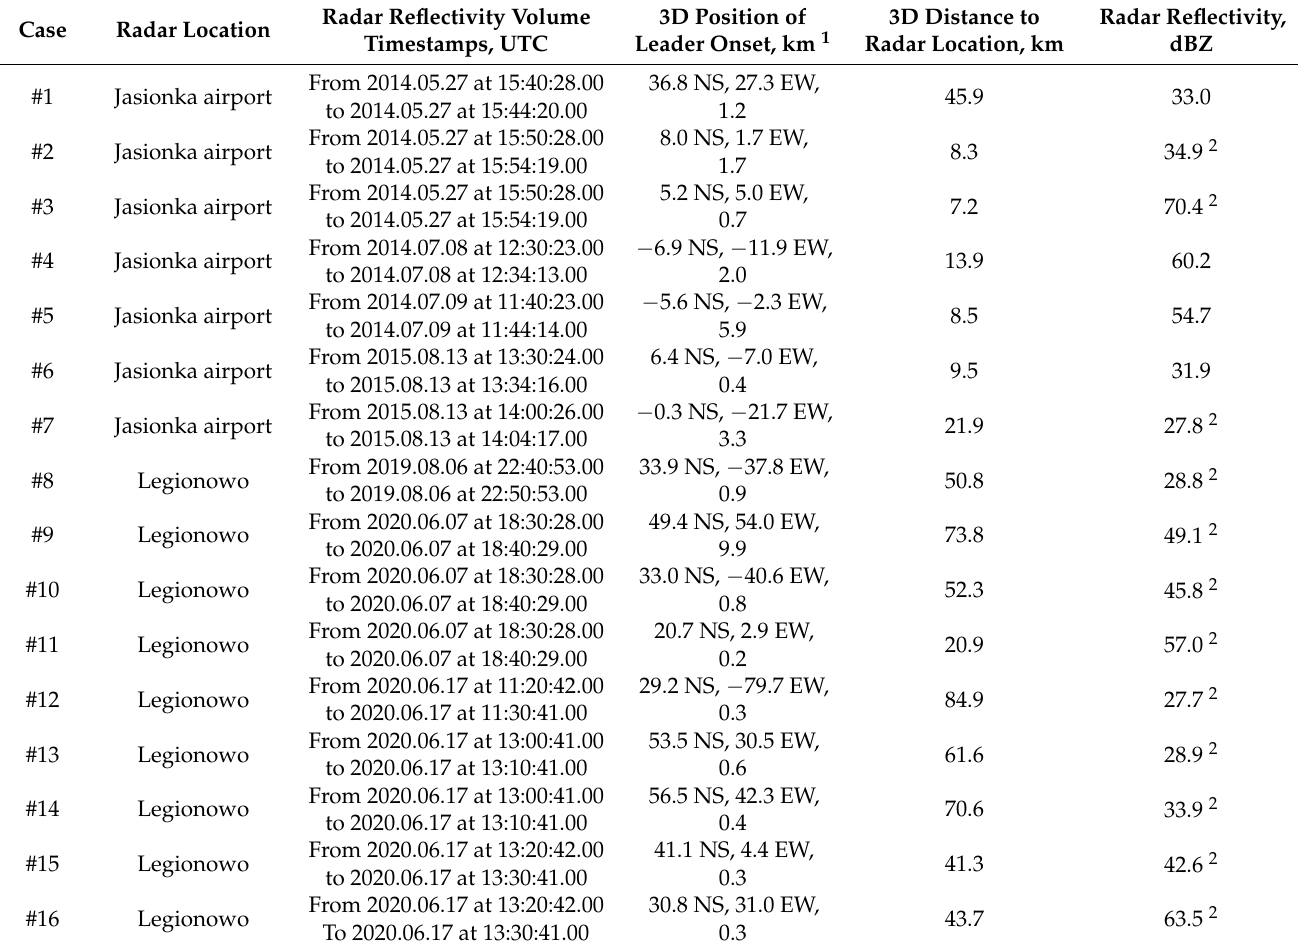
Table 4. Doppler radar reflectivity in the area of positive lightning leader